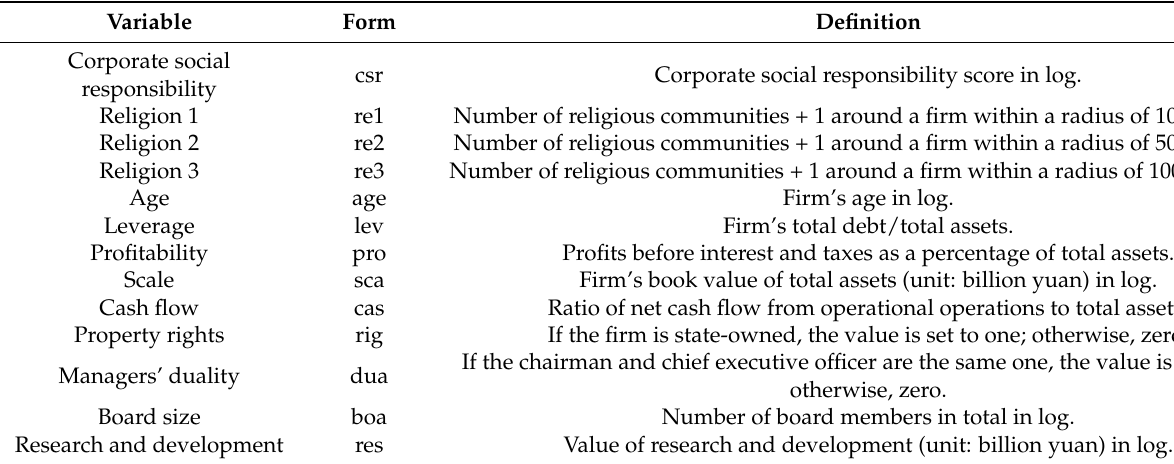
Table 1. Results of variable